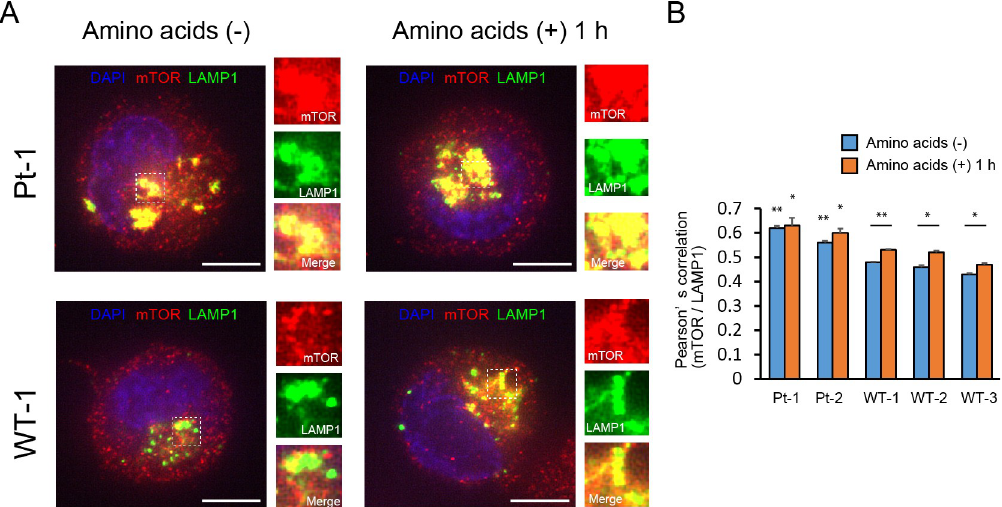
Fig 2. Amino acid-insensitive constitutive lysosomal localization of mTOR in the patients. (A) Cells were starved, or starved and re-stimulated with amino acids for 1 h. The localization of mTOR and LAMP1 was determined by immunofluorescence. Representative images of co-localization of mTOR (red) and LAMP1 (green) in patient 1 and wild type 1 are shown on behalf of each patient and control. Right panels show the enlarged view of co-localizing area. DAPI, nuclear staining (blue). Scale bars, 5 μ m. See also S1 Fig for patient 2, wild type 2 and 3. (B) Quantification of co-localization between mTOR and LAMP1. Co-localization levels of patient 1 and 2 were significantly higher than those of controls under each condition. � p < 0.05. �� p <